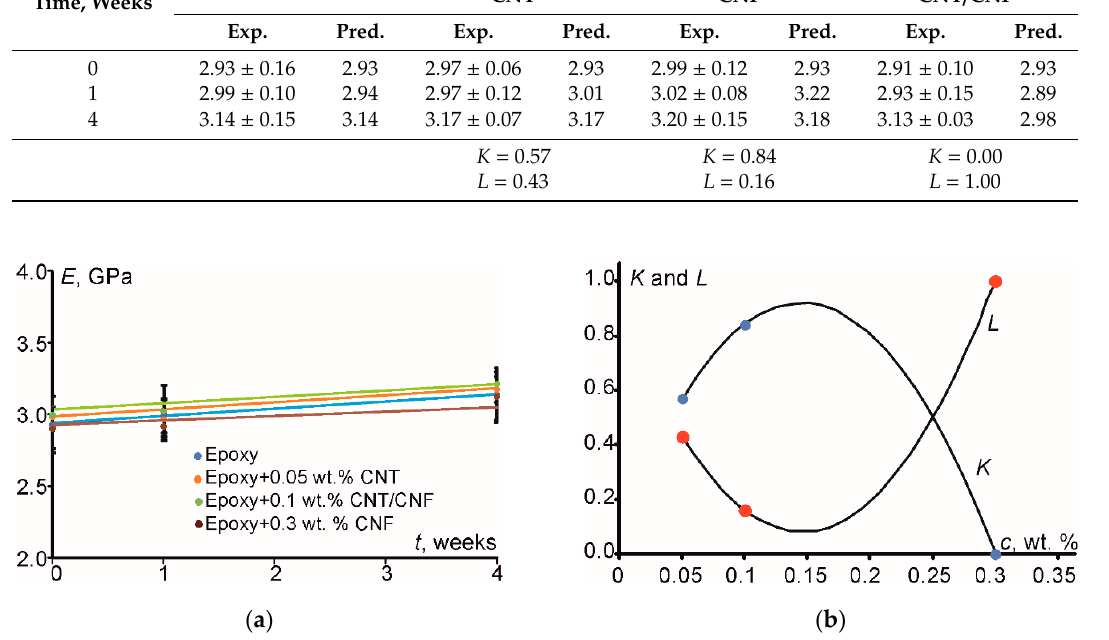
Figure 8. Experimental results and theoretical prediction by using PPM for ( a ) the elastic modulus variation of the investigated materials (indicated in the legend) with time of immersion in water at 70 °C and ( b ) variation of the degrees of adhesion ( K ) and dispersion ( L ) with filler concentration for specimens aged at 70 °C (dots—experimental data, lines—PPM prediction).